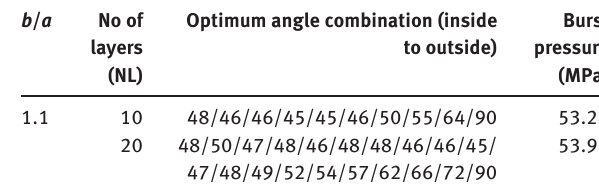
Table 2: Optimum ply angles and the maximum burst pressure obtained using the